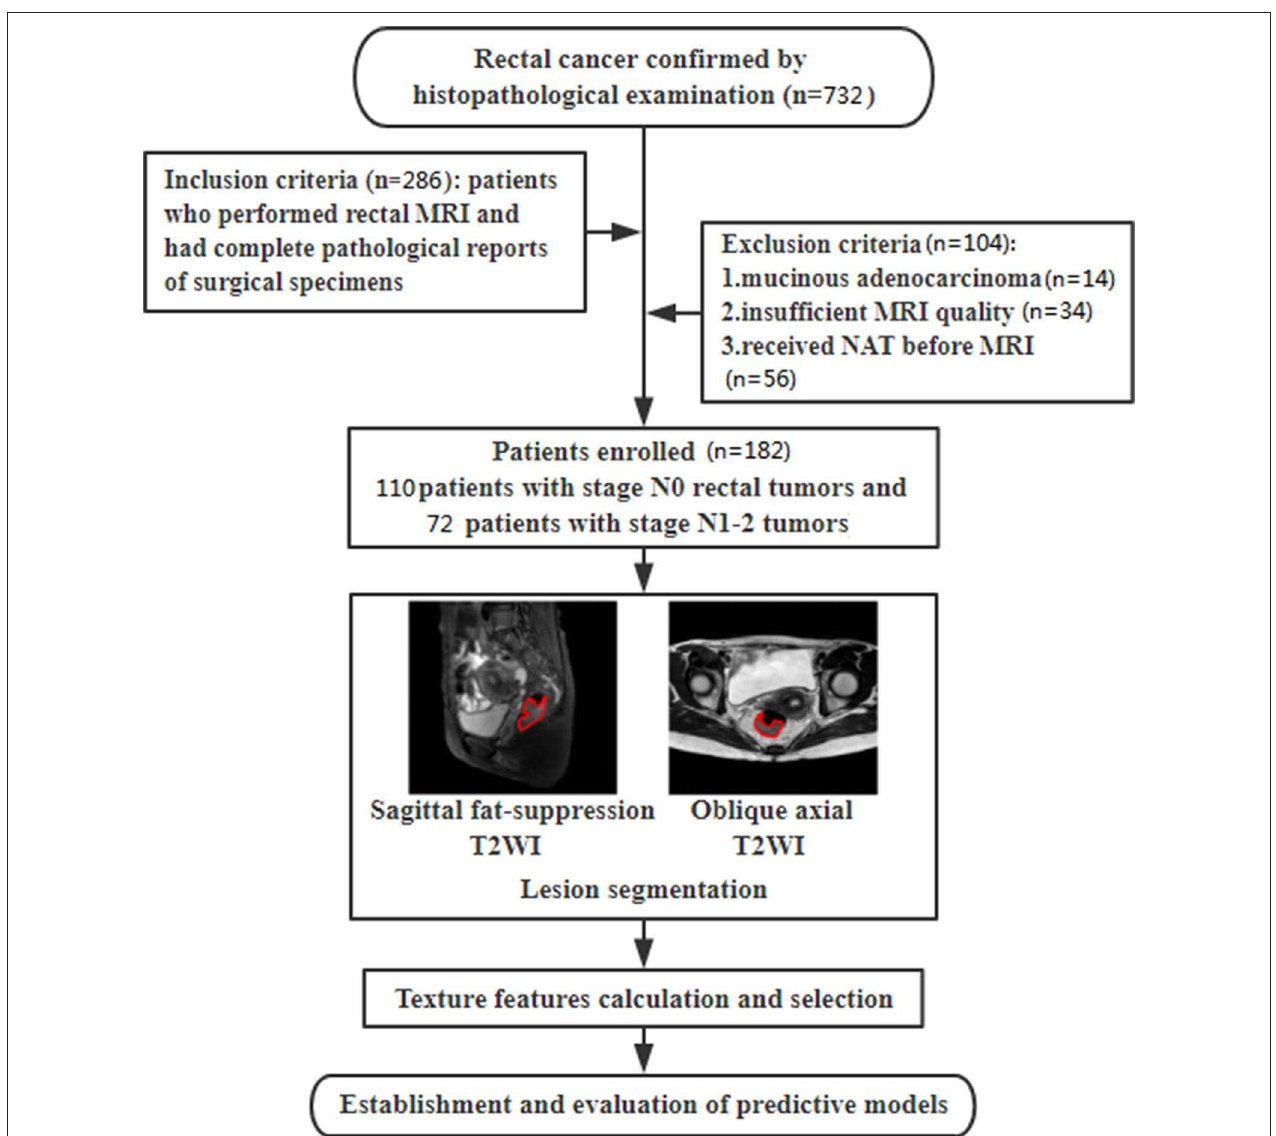
FIGURE 1 | Flowchart of this study for discriminating N